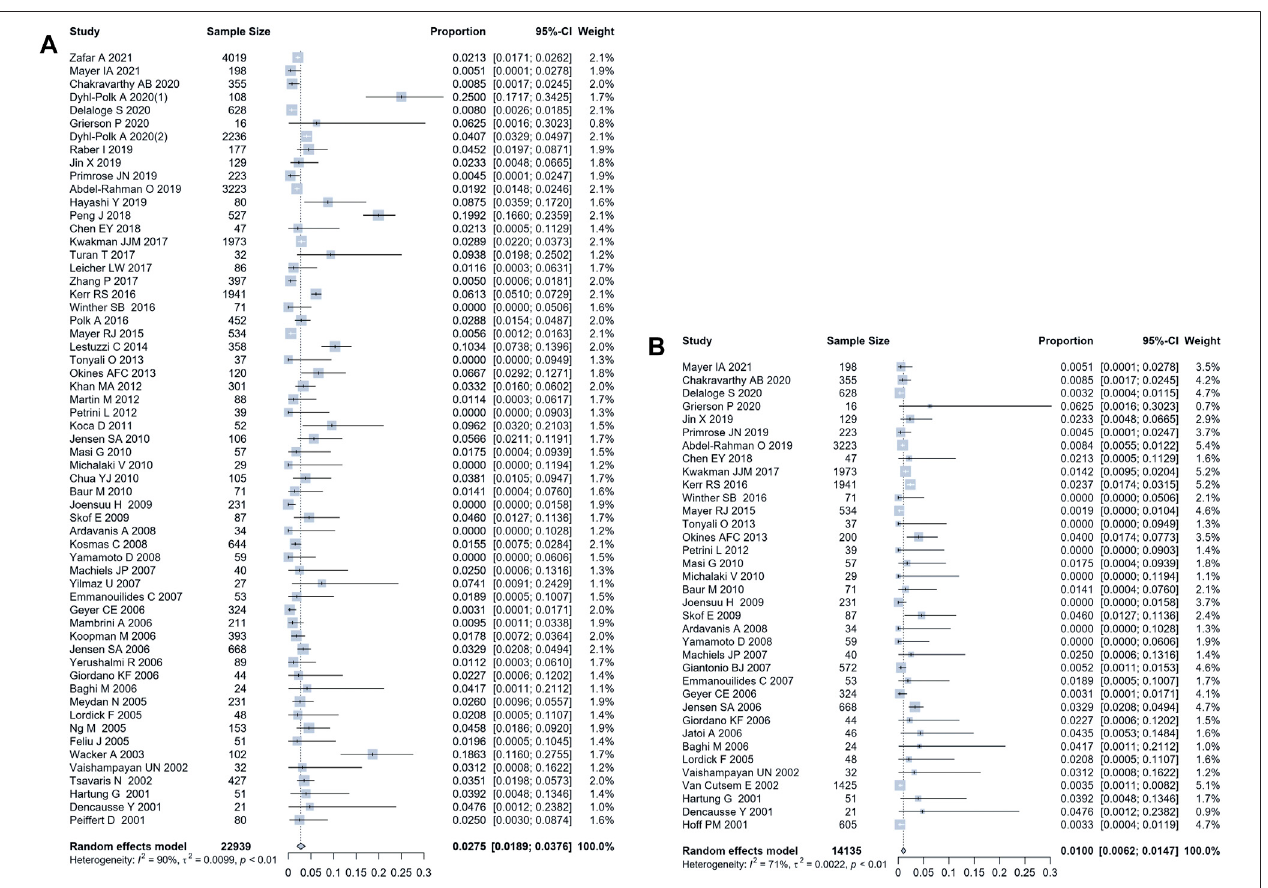
FIGURE2| Forestplotoftheincidenceof fl uoropyrimidine-relatedcoronarydisorders. (A) thepooledincidenceofall-gradeadversecoronaryevents,byarandom- effect model analysis, was 2.75% (95% CI 1.89% – 3.76%); (B) the pooled incidence of grade 3 or higher adverse coronary events, by a random-effect model analysis, was and 1.00% (95% CI 0.62% – 1.47%).